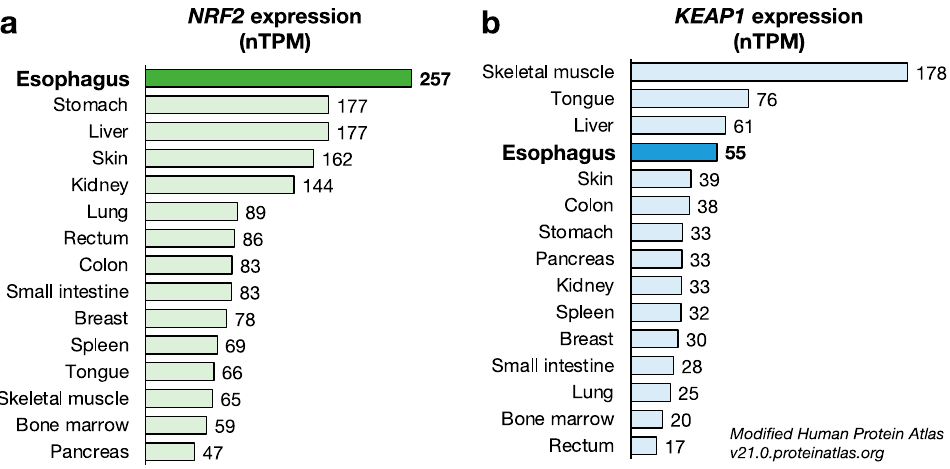
Figure 2. Expression levels of NRF2 and KEAP1 protein-coding transcripts in various tissues. ( a ) Expression level of NRF2 protein-coding transcripts in various tissues. Of note, the NRF2 expression level in the esophagus was the highest among the tissues examined. ( b ) Expression level of KEAP1 protein-coding transcripts in various tissues. The KEAP1 expression level in the esophagus is comparable to that in the tongue and the liver. Data were obtained from Human Protein Atlas v21.0.proteinatlas.org. nTPM: normalized protein-coding transcripts per million.